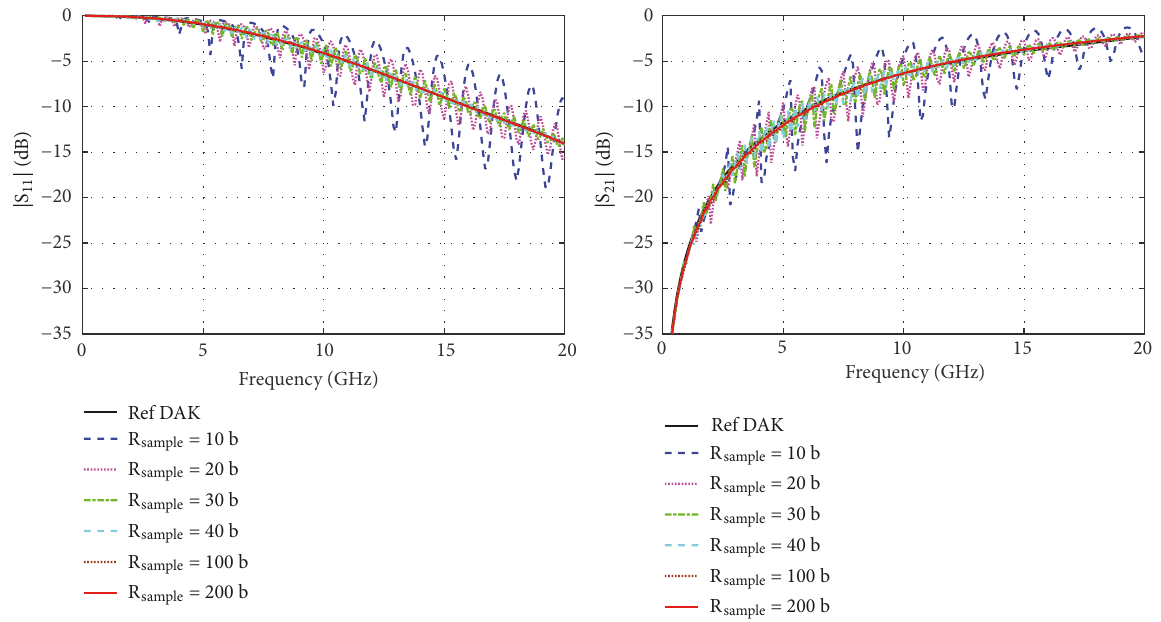
modes at the input/output coaxial lines, for different values of n